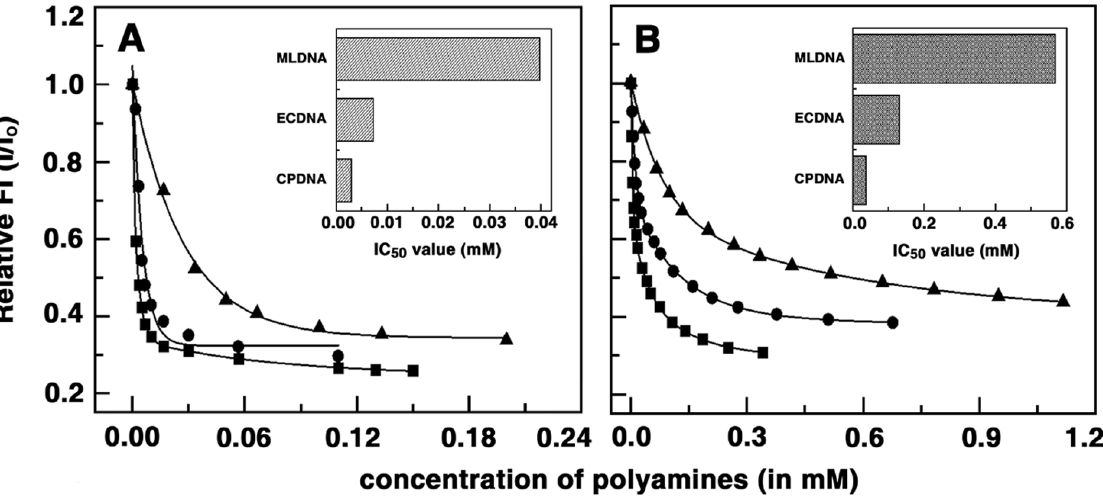
N -), ML DNA (- m -) and (B) spermidine